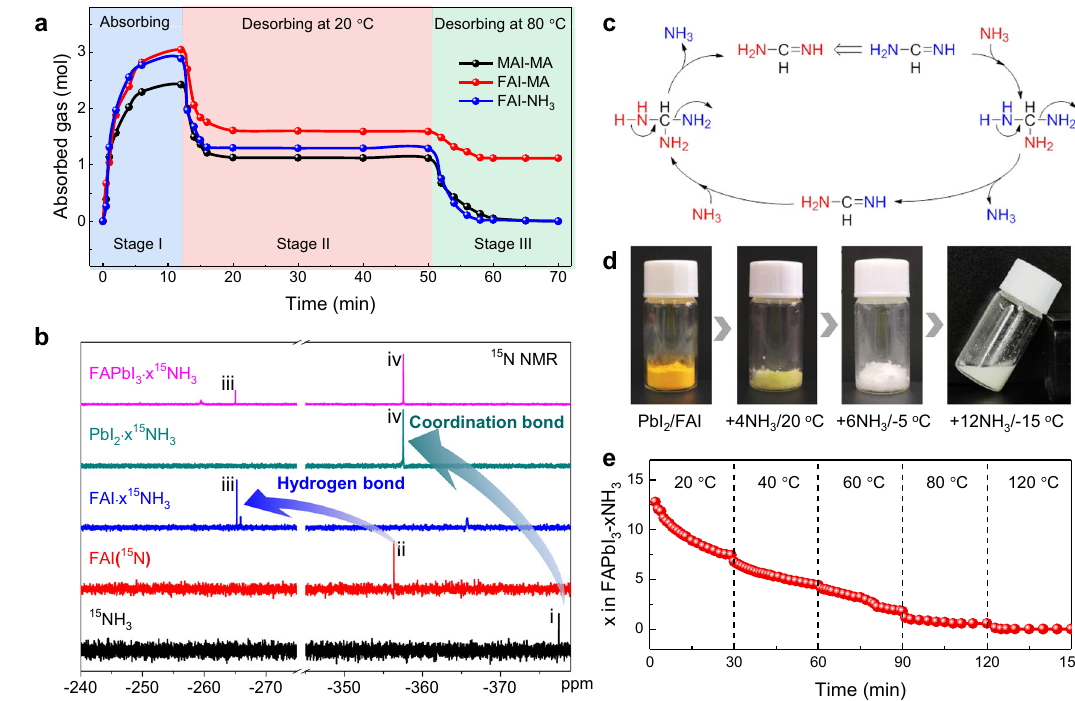
c Reaction mechanism of transimination reactions between NH 3 and FAI. d The photographsofPbI 2 /FAIpowderinNH 3 atmosphereunderdifferenttemperatures. e The calculated x value of FAPbI 3 ·xNH 3 complex in an open condition under dif- ferent